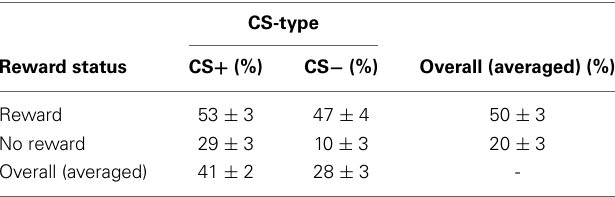
Table 1 | Contingency awareness ratings after